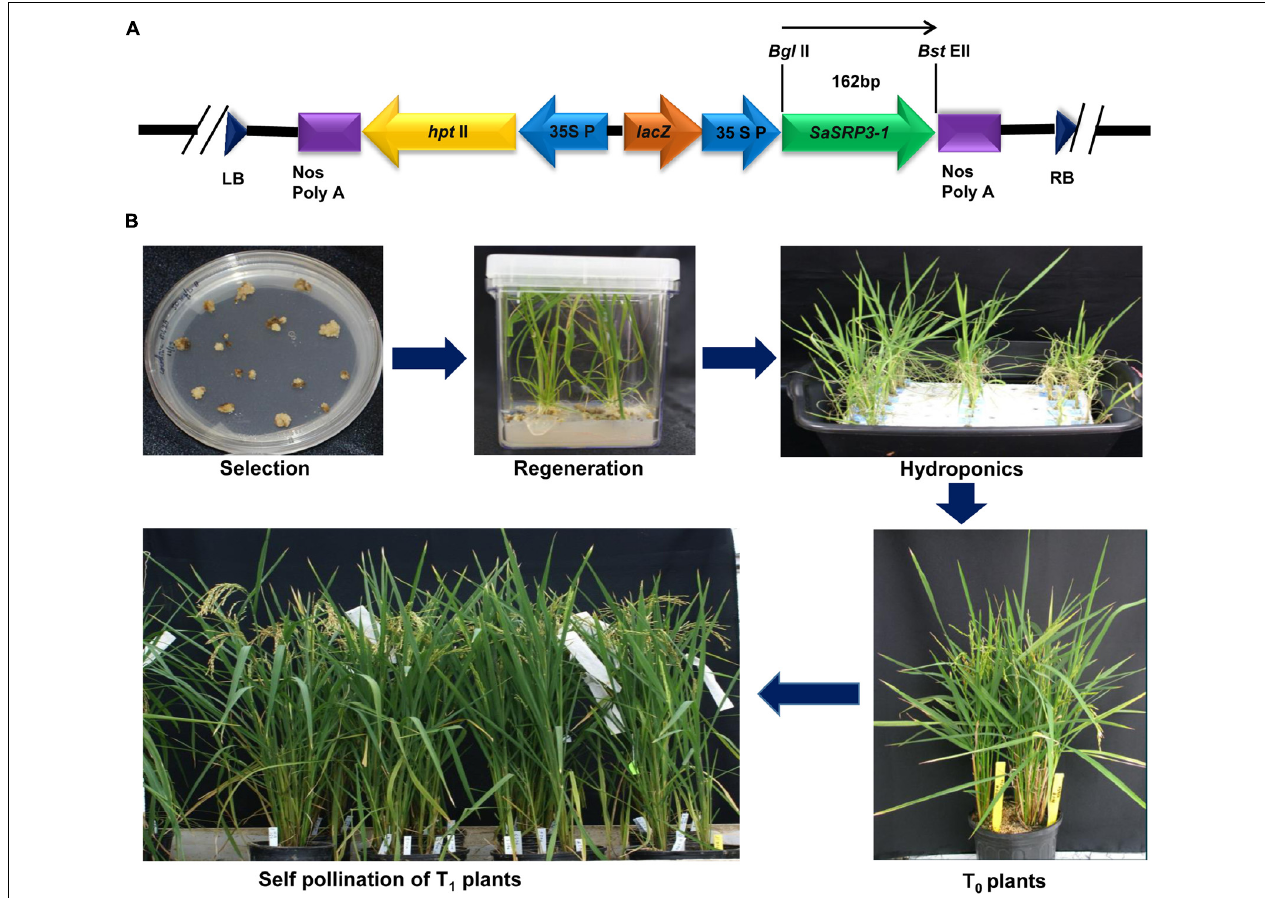
FIGURE 2 | Plasmid construction for the gene SaSRP3-1 and development of transgenic plants. (A) The schematic diagram of the partial linear plasmid vector and position of the gene SaSRP3-1 . The diagram depicts the details of the pCAMBIA1305.2 vector containing right and left borders, SaSRP3-1 gene between Bgl II and Bst EII sites, 35S CaMV promoter, plant selection marker ( hptII ), multiple cloning sites, and termination sites; (B) Transformation and regeneration of Cocodrie- SaSRP3-1 transgenic rice plants showing selection, regeneration, and self-pollination of transgenic plants after Agrobacterium mediated transformation.